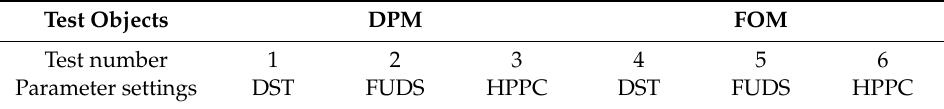
Table 9. Experiments under di ff erent models and di ff erent test conditions.